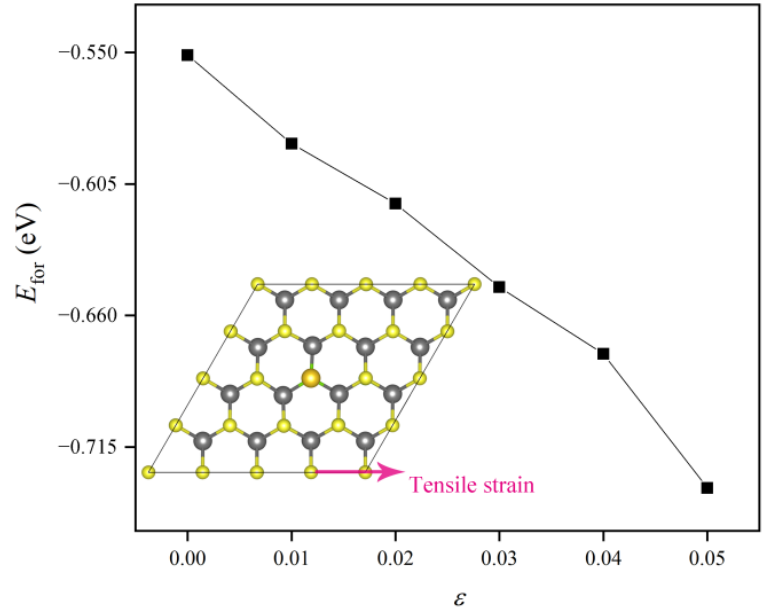
Figure 2. Formation energy of Au/WSSe under different tensile strain.